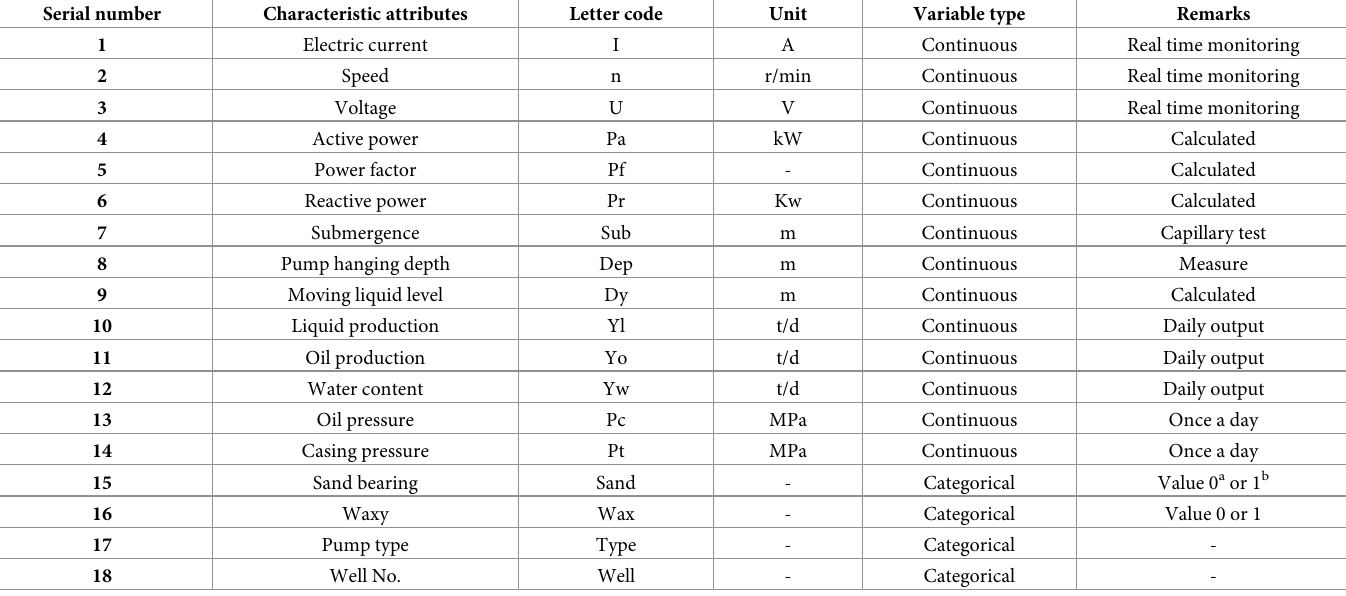
Table 1. Working parameters of submersible screw